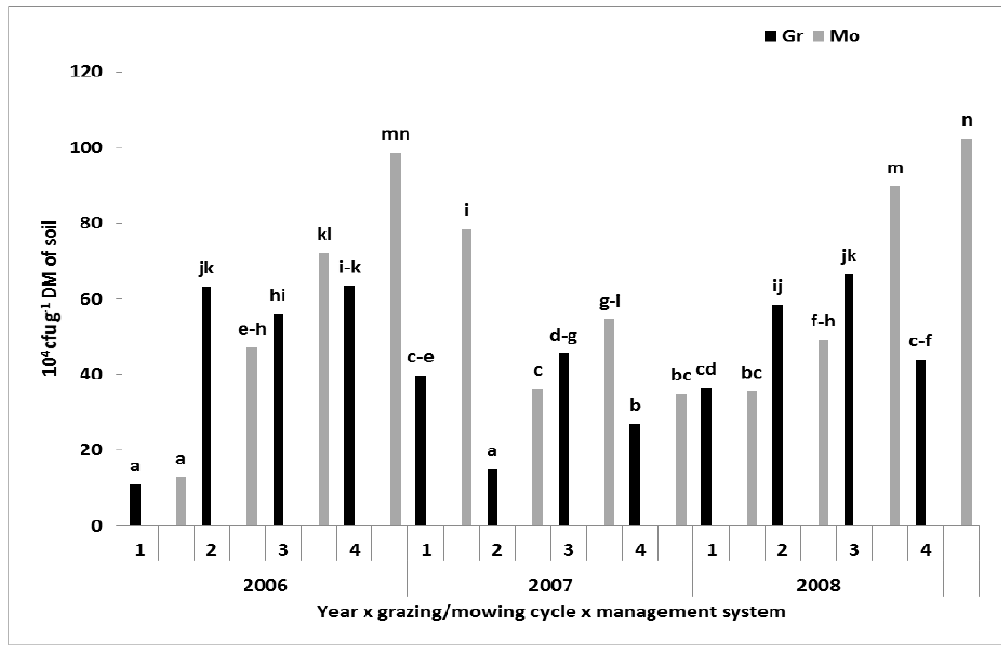
Figure 3. Effect of the grassland management in consecutive cuts during the growing season on the actinobacteria count. a The same letter indicates a lack of significant differences within the treatment actinobacteria count. a The same letter indicates a lack of significant di ff erences within the treatment ( p < 0.05). ( p <